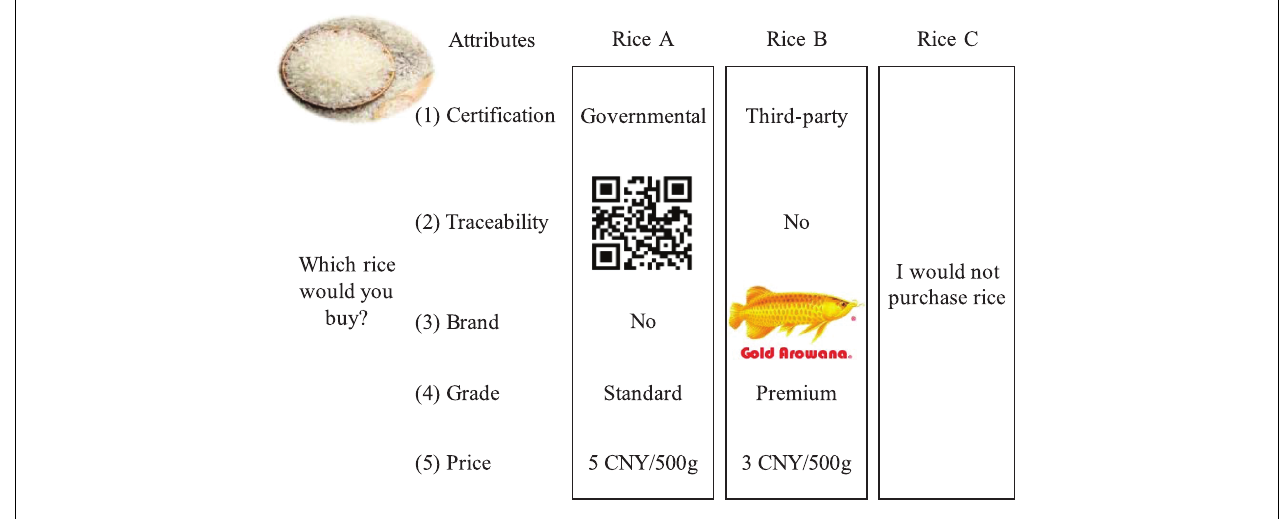
FIGURE 2 | A rice choice set